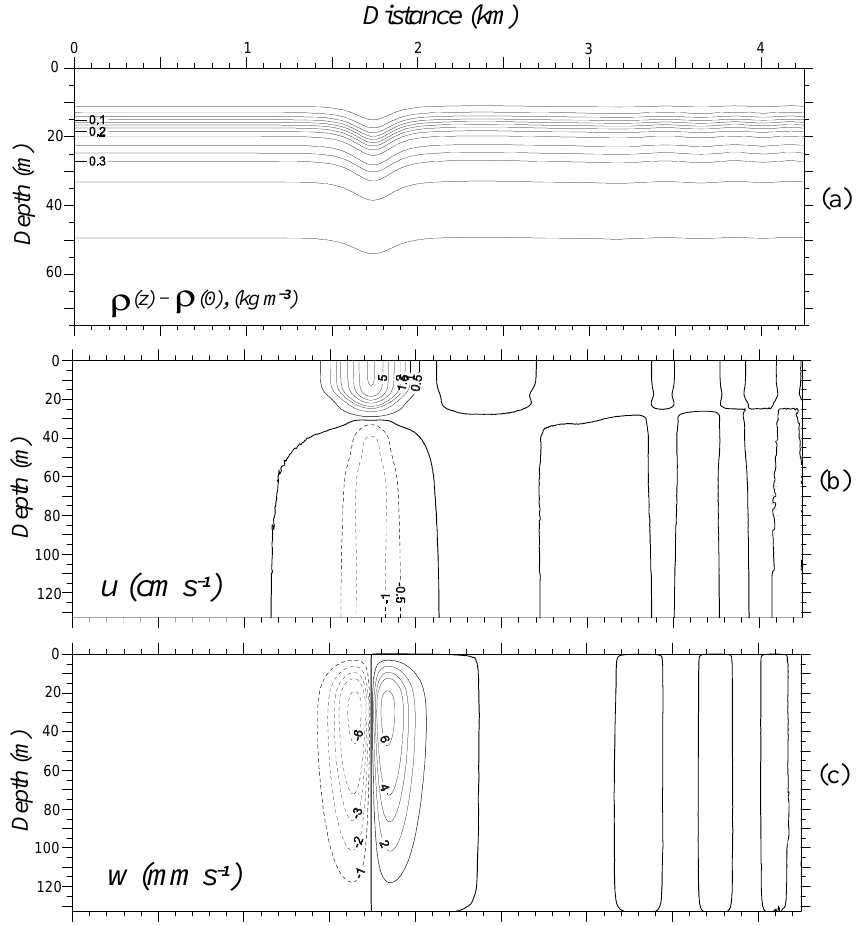
Fig. 7. The result of the penetration of a 5m SIW behind the underwater sill A - A along the cross section 2 (see Fig. 1). All designations are the same as in Fig.